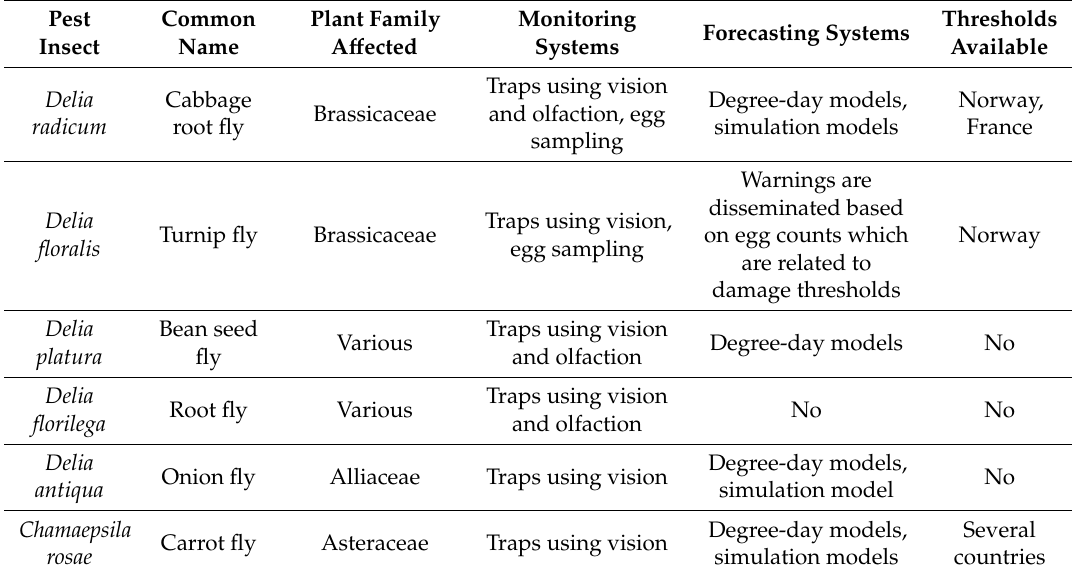
Table 1. Main root-feeding fly pests of vegetable crops and the types of decision-support tools available in Western Europe (see text for further